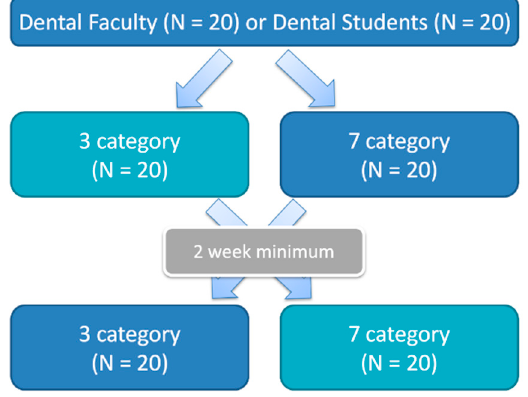
Figure 6. Study design showing evaluator progression with cross